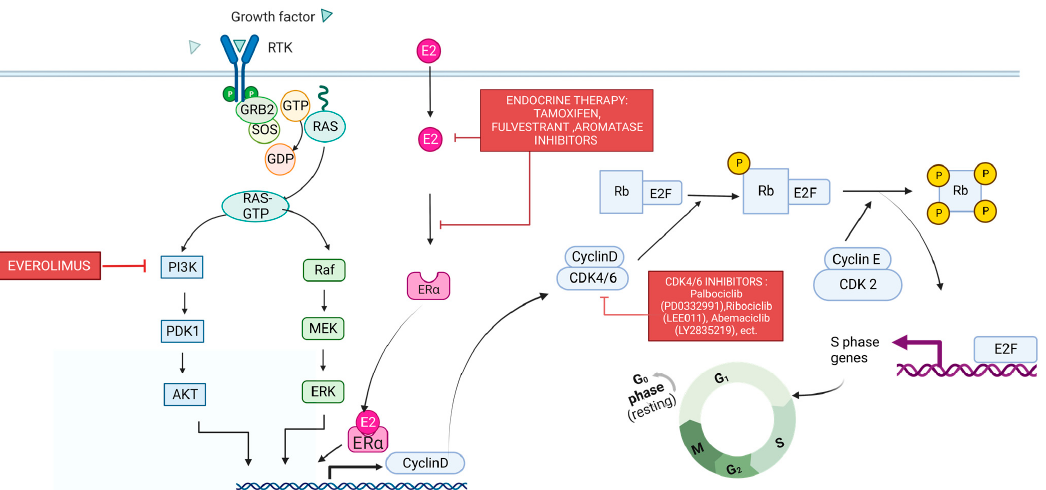
Figure 7. A diagram of how the binding of CDK4/6 relates to cell cycle progression. RAS signaling and estrogen receptor (ER) activation lead to the production of cyclin D. The binding of Cyclin D to CDK4/6 helps push the cell cycle from the G1 to S phase via Rb phosphorylation. The nodes at which current therapies target the pathway are included as well. Created with BioRender.com.